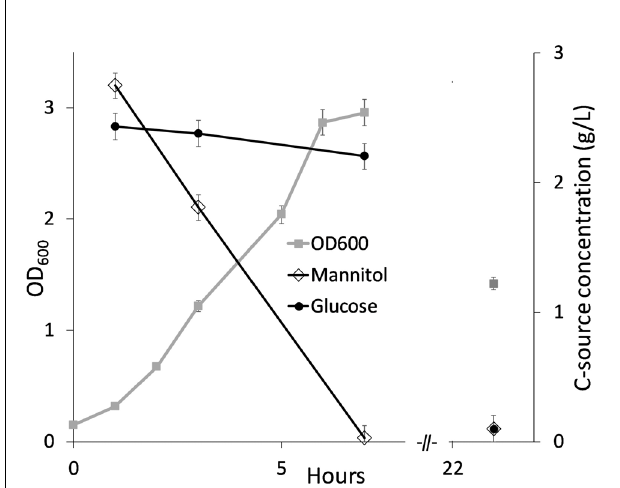
FIGURE 3 | Bacillus methanolicus MGA3 cultivated in MVcMY minimal medium with mannitol and glucose (2.5 g/L each). Consumption of mannitol and glucose was measured over time and shown as remaining sugar in culture medium. Maximum deviation for triplicate cultivations is presented.